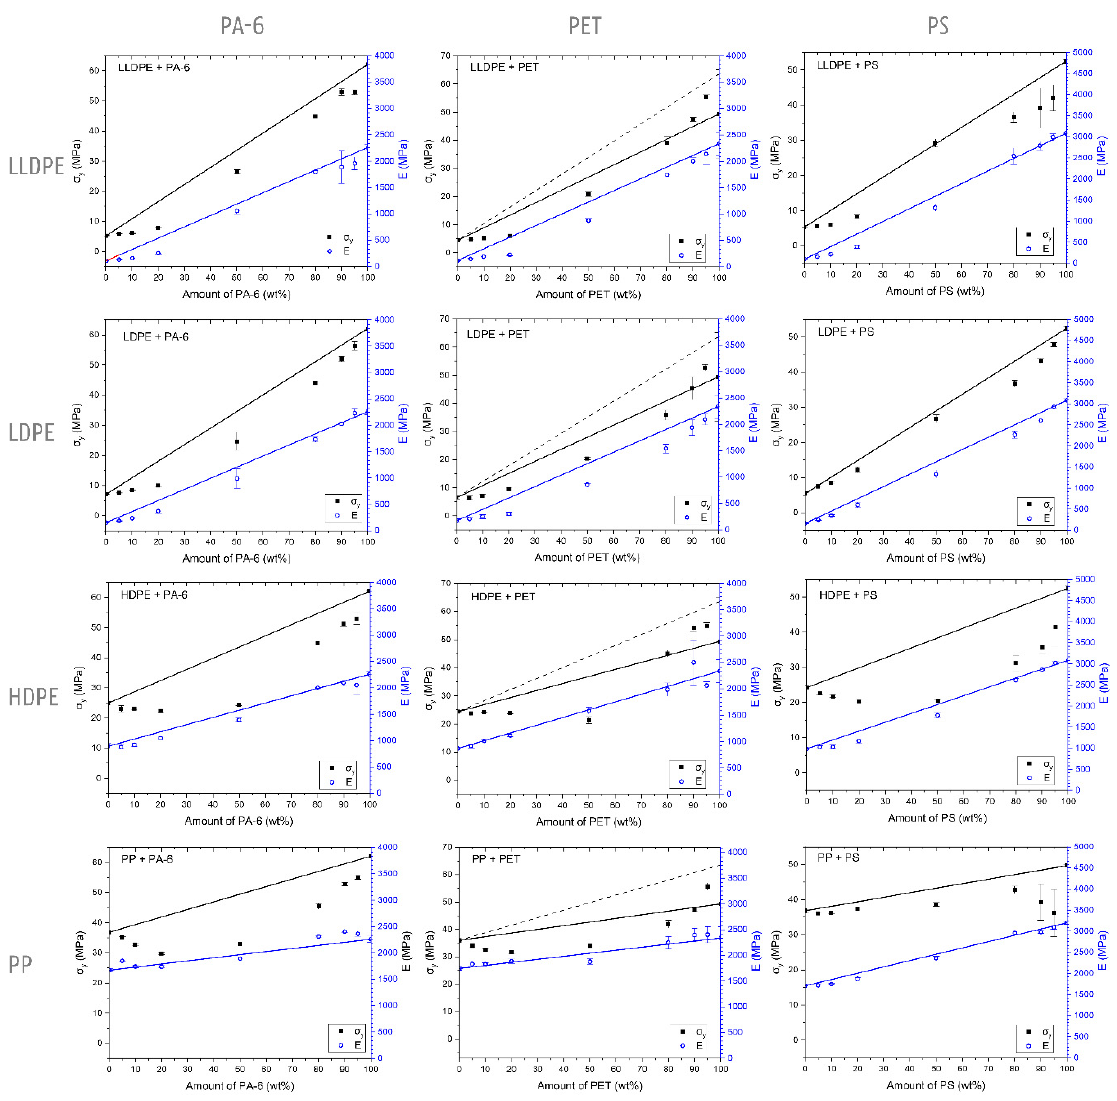
Figure 2. Overview of the σ y ( ■ ) and E ( ○ ) values for the tested blend series. Lines present the prediction based on the additivity rule for σ y (black line) and E (blue line). The dashed line (PET blends) presents the predictions for σ y for a PET value of 63.6 MPa (average of PET with ε b of minimum 4%).